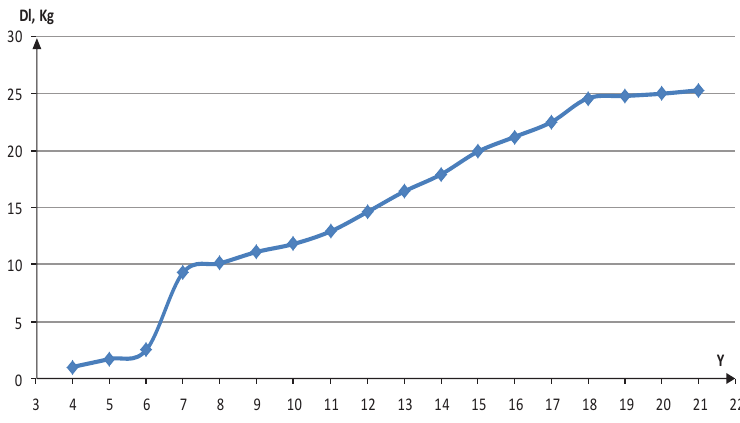
Fig. 4. Dynamic of right hand dynamometry indicators’ change (Dp, Kg) from Y (Y, years)